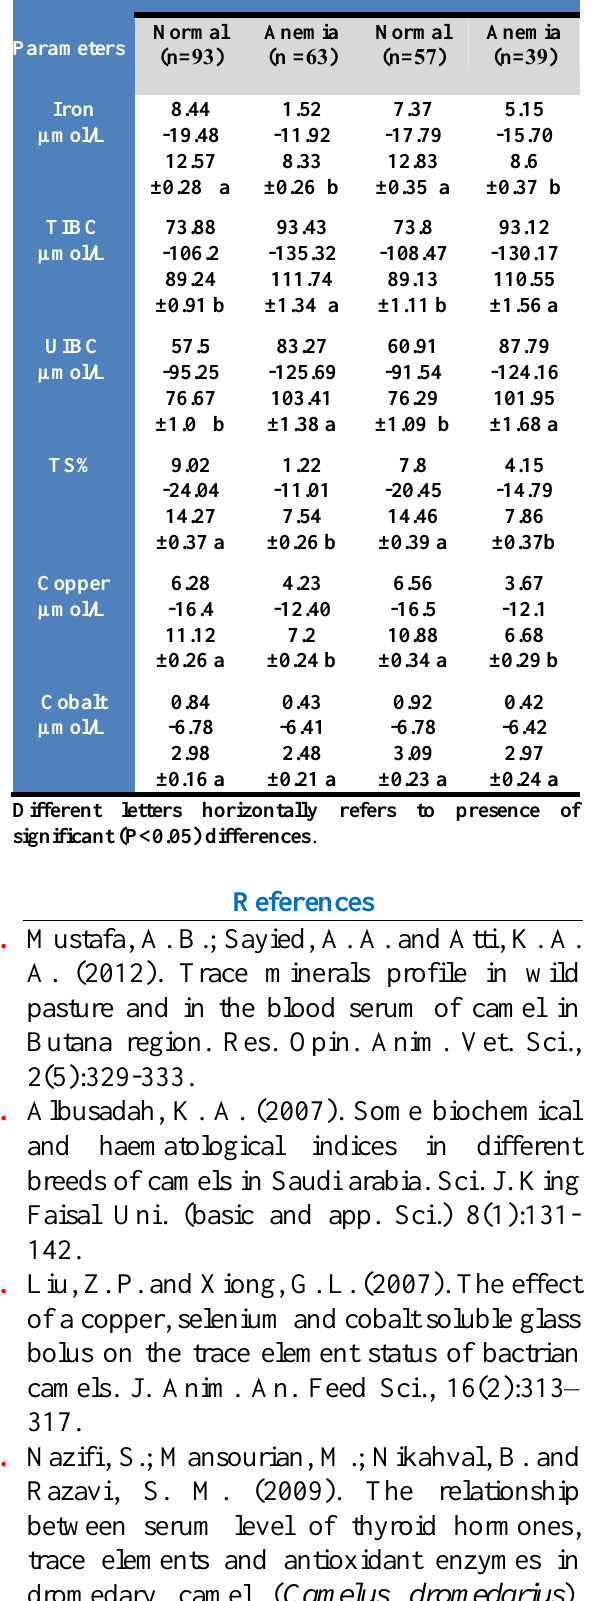
Table, 3: The biochemical parameters for both age groups in normal and anemic camels; ranges and means ± SE. 1 –5 years Parameters